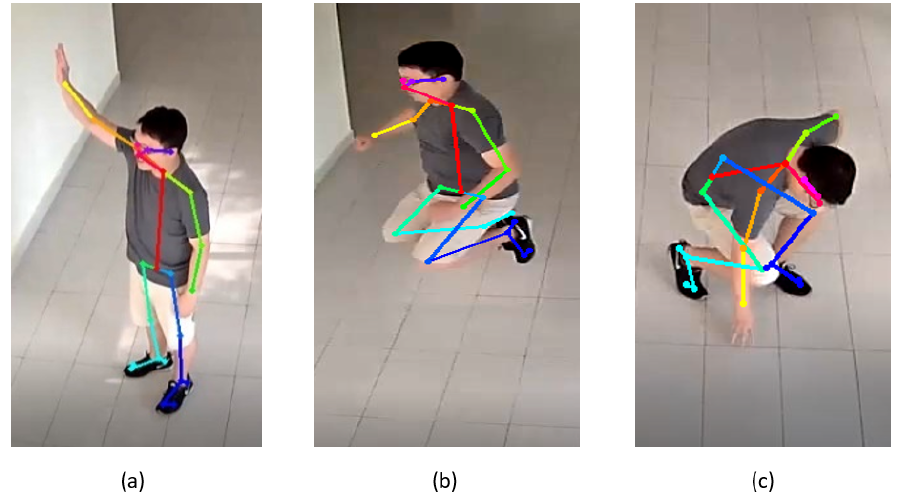
Figure 4. Skeleton detection of few actions from MCAD dataset. ( a ) Wave ( b ) Jump ( c )